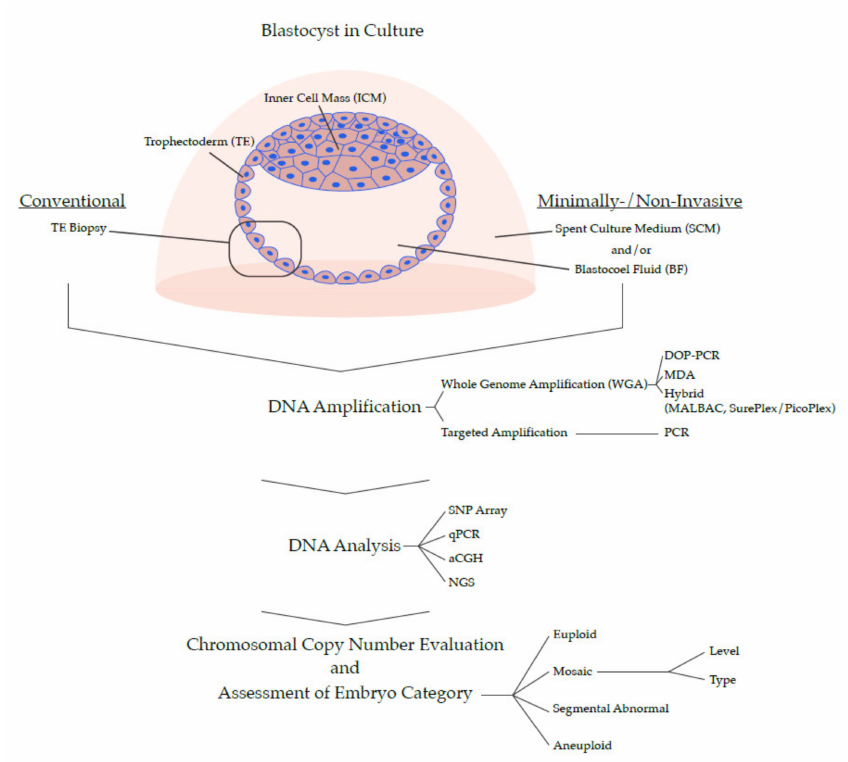
Figure 1. Overview of PGT Methods for 24-Chromosome